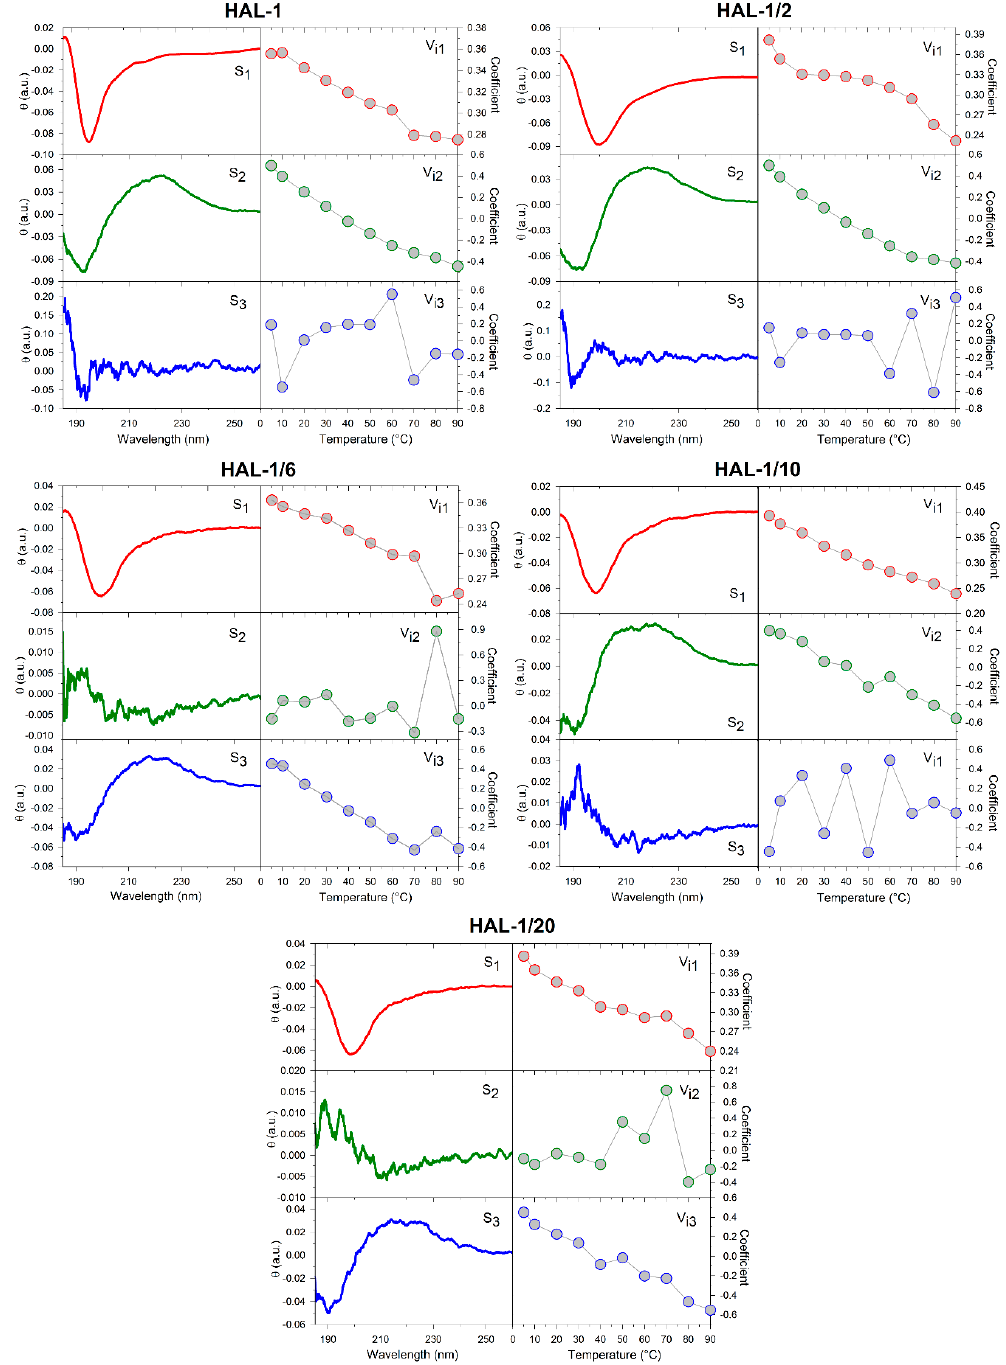
Figure A1. PCA results applied to the set of thermal dependence of ECD spectra (from 5 to 90 °C) of HAL-1 and its analogs. S j represents the three most significant subspectra, and V ij represents the appropriate coefficients indicating the relative contribution of the corresponding subspectrum.